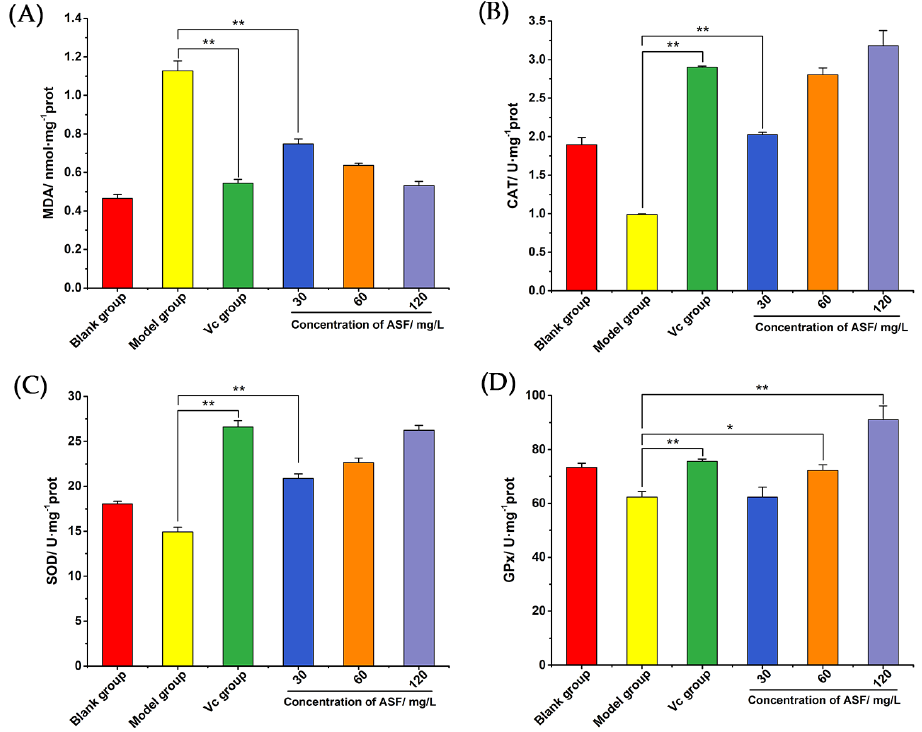
Figure 3. The effects of total flavonoids on MDA and antioxidant enzymes in RAW 264.7 cells. ( A ) The effect of A. senticosus flavonoids on the cellular concentration of MDA. ( B ) The effect of A. senticosus flavonoids on the activity of CAT. ( C ) The effect of A. senticosus flavonoids on the activity of SOD. ( D ) The effect of A. senticosus flavonoids on the activity of GPx. Note: For the comparison between the two groups, * indicates significant difference at p < 0.05. ** indicates extremely significant difference at p <